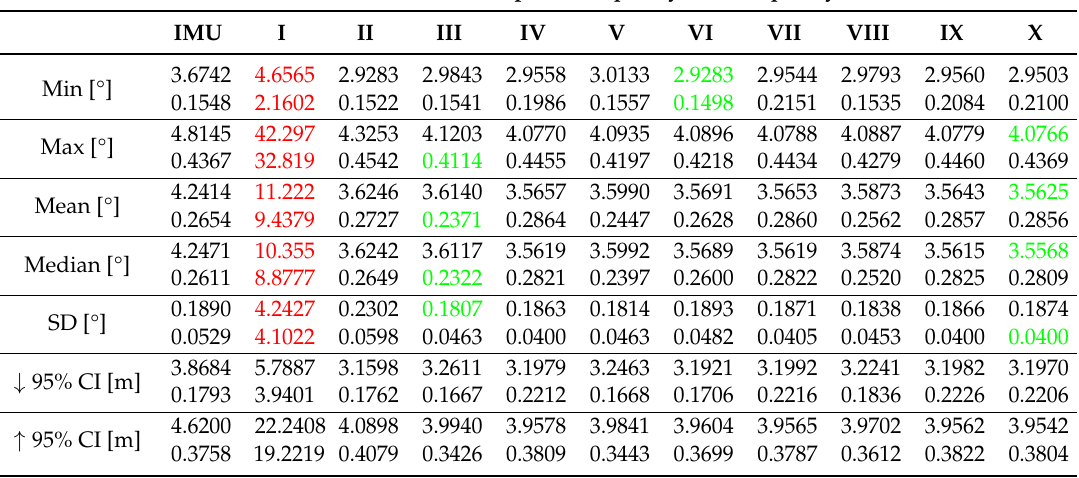
Table 5. Mean error (ME) for orientation by means of 500 replications. The Roman numerals refer to respective state constraints applied regarding Table 3. Each of the seven characteristic values (minimum, maximum, mean, median, SD as well as lower bound ( ↓ ) and upper bound ( ↑ ) of the 95% CI) are divided into two additional rows regarding moderate (above) and accurate (below) IMU. The largest (red) and lowest (green) estimates are marked for first five